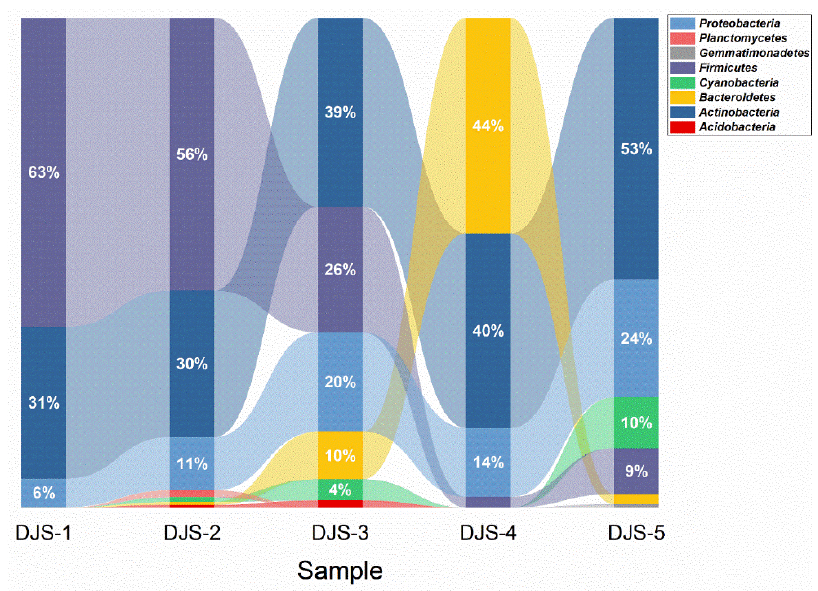
Figure 1. The average relative abundance of the major bacterial phyla in the fresh snowfall sam- ples.